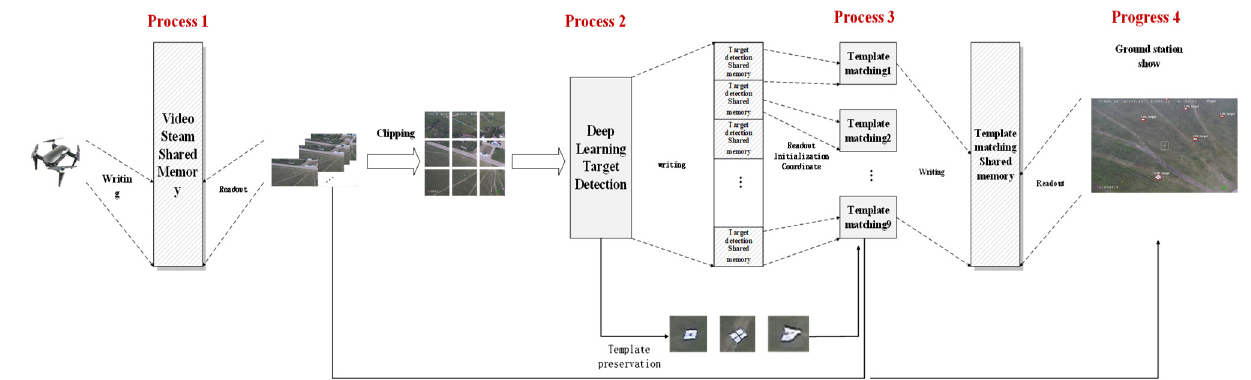
Figure 7. Overall system flow.